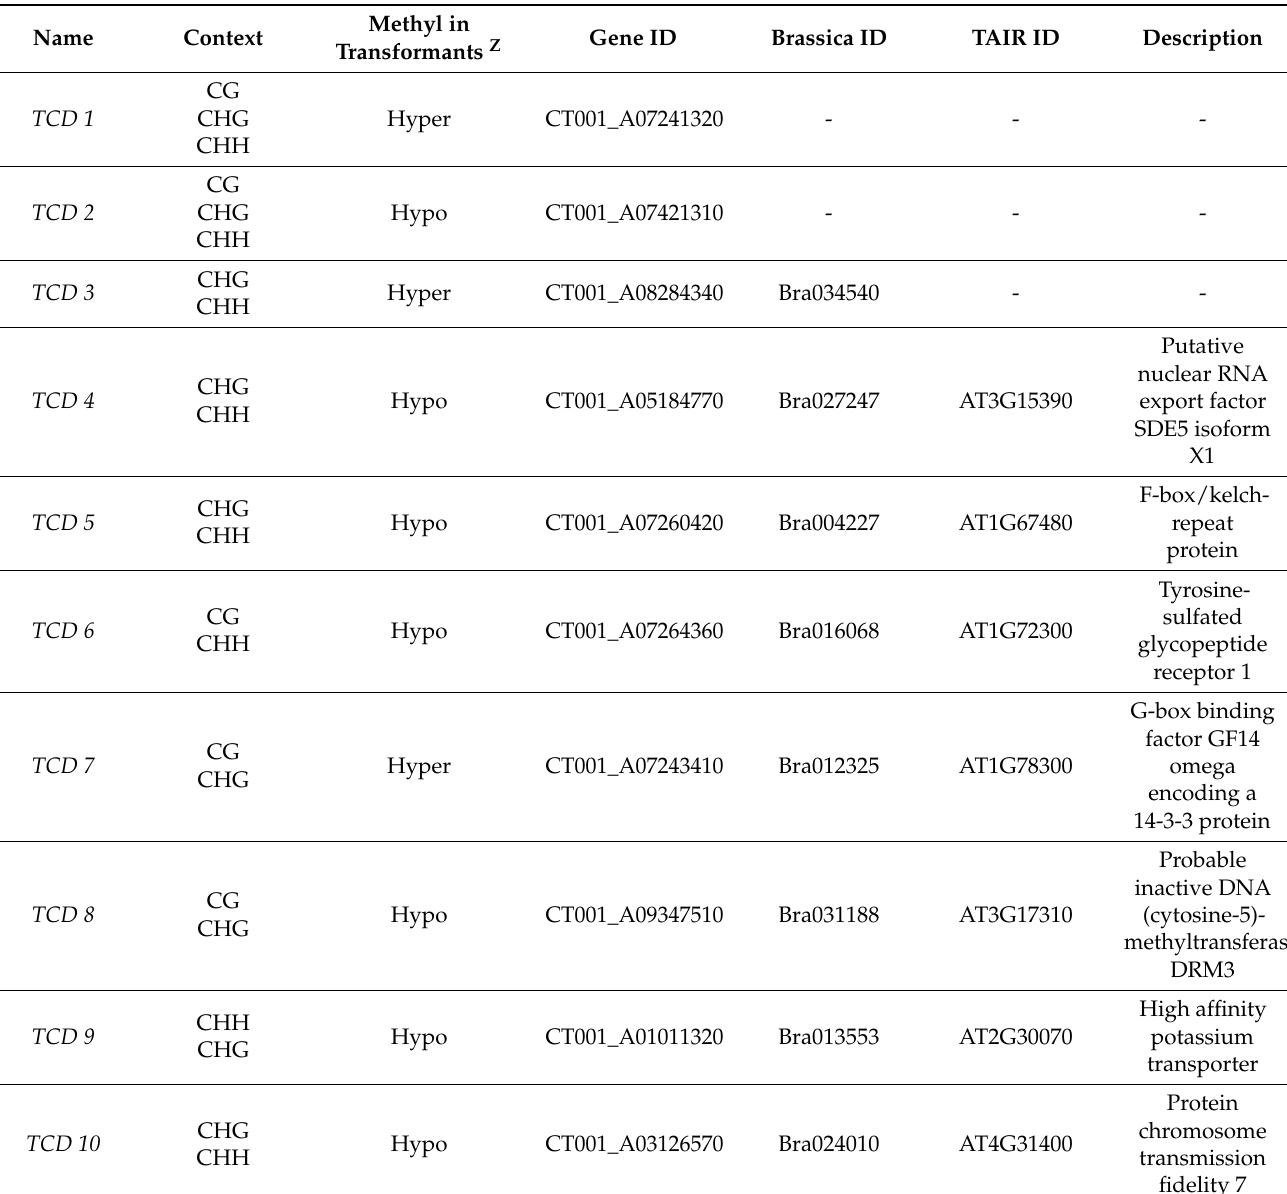
Table 2. Information of genes within the transfomant-conserved DMRs (TCDs) in the transgenic